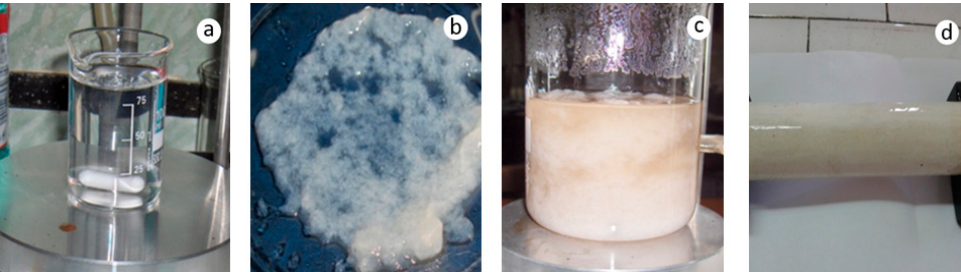
Figure 2. The stages of preparation of rigid polyvinyl alcohol-bacterial cellulose (PVA-BC) membrane on ceramic support: ( a ) PVA solution, ( b ) wet ground BC, ( c ) PVA-BC-glutaraldehyde (GA) mixture, ( d ) membrane applied on support.